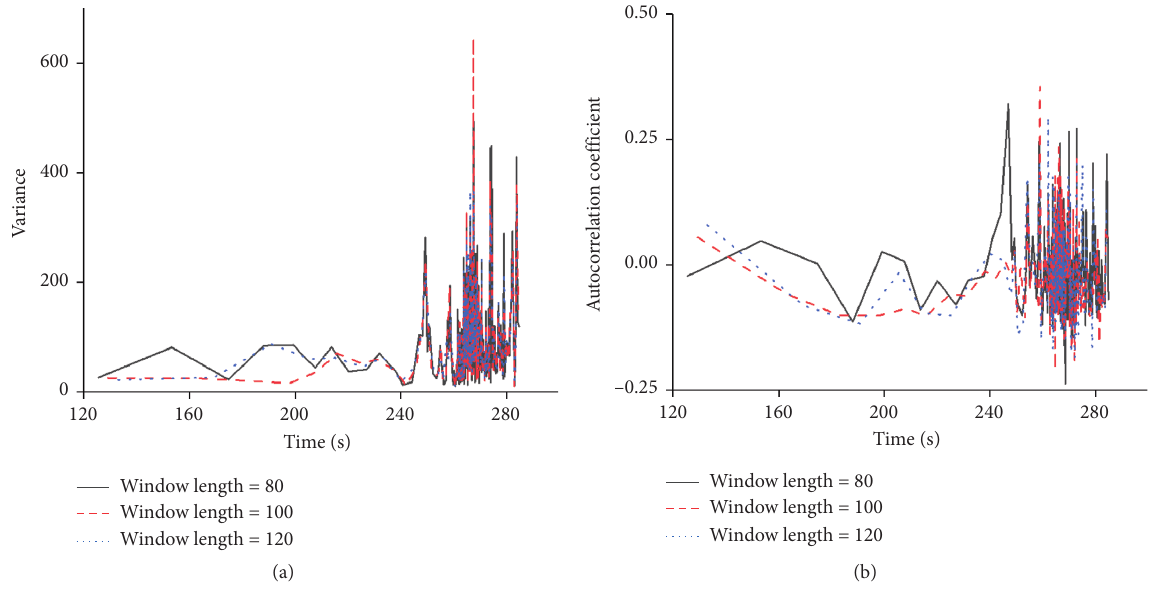
Figure 7: Variance and autocorrelation coefficient curves of AE counts with different window lengths under the same lag step length: (a) variance; (b) autocorrelation